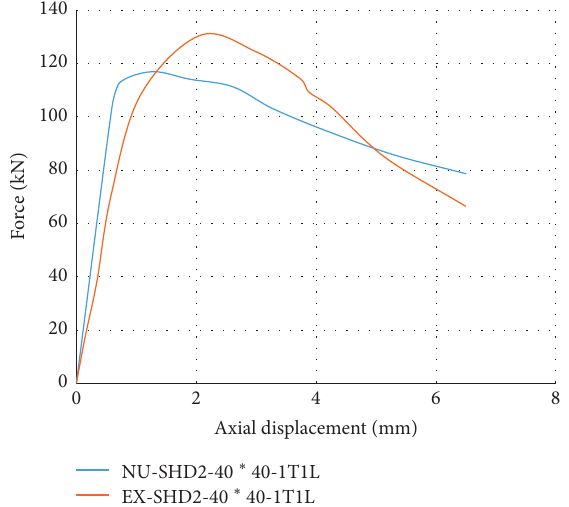
Figure 9: Force-displacement diagram of a modeled and laboratory sample.